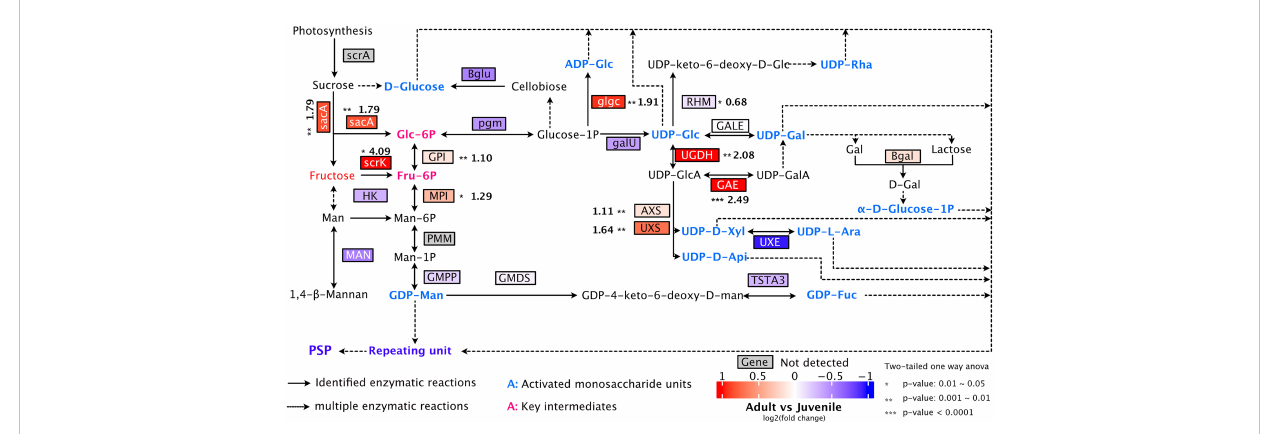
FIGURE 8 Proposed pathway for polysaccharide biosynthesis in P. sibiricum . The solid arrows represent identi fi ed enzymatic reactions, and the dashed arrows represent multiple-step enzymatic reactions. Fructose is the metabolite with higher accumulation in adult rhizomes. Key intermediates are colored in rose red and activated monosaccharide units are colored in blue. Asterisks indicate signi fi cant difference in the gene expression between juvenile and adult rhizomes. Numbers (in bold) next to asterisks are fold changes of the expression levels of indicated genes